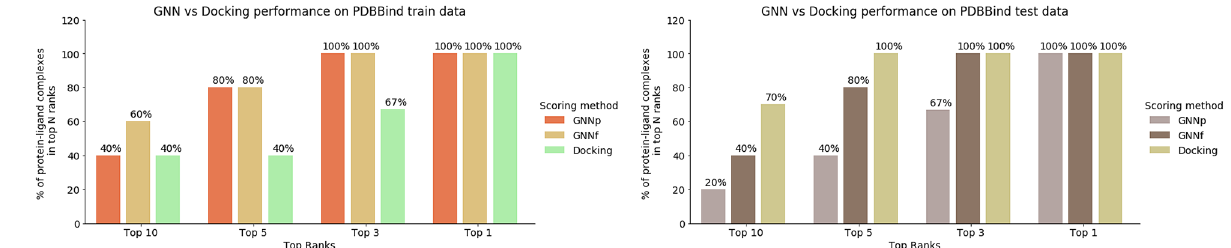
Figure 2. Comparison of the GNN P and GNN F models with docking. Each bar corresponds to the percentage of protein–ligand complexes identified in top-N ranks which have an RMSD less than 2 Å from the crystal